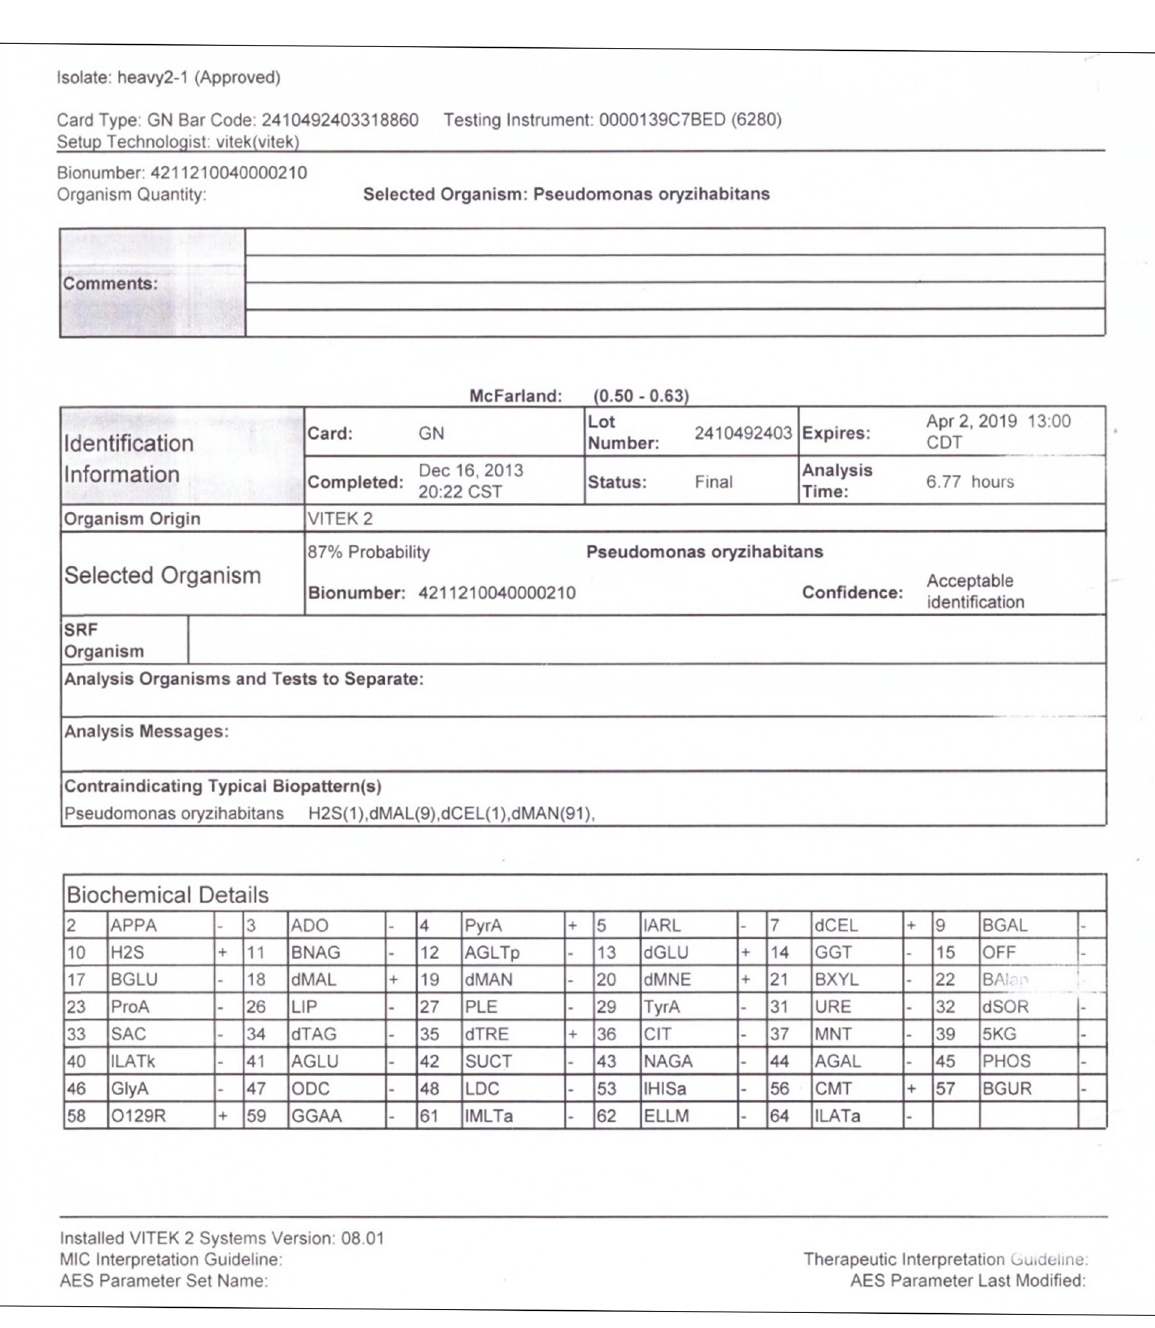
Figure A1: Identi fi cation of microbiota in ileum P. orizihabitain by VITEK